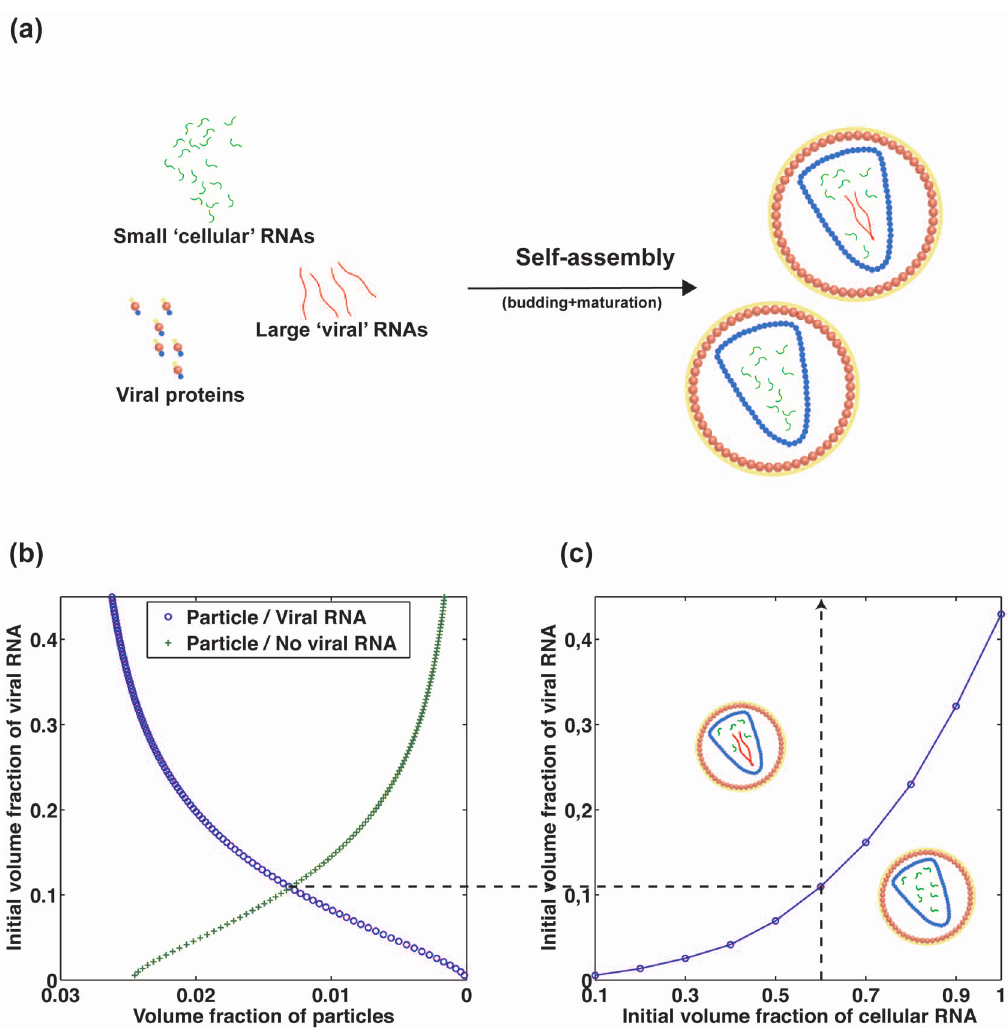
Figure 5. Model of entropic selection of viral genome at fixed particle size. (a) Cartoon of the self-assembly. The model is specialized to bimodal products of self-assembly, in which the size of particle are equal and the RNA content are different. (b) Typical large RNA titration computed thanks to the model detailed in File S1. The value of parameters chosen for the calculation are found in the material and methods . Blue circles correspond to particles with large RNA, and green crosses correspond to particles lacking large RNA.(c) Phase diagram small RNA/large RNA . The boundary for which the concentration of both particles are equal is shown by blue filled circles. The line joining the circles is drawn to guide the eye.